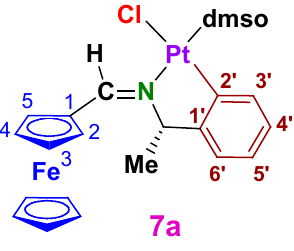
Figure A2. Atom labelling scheme for compound 7a .